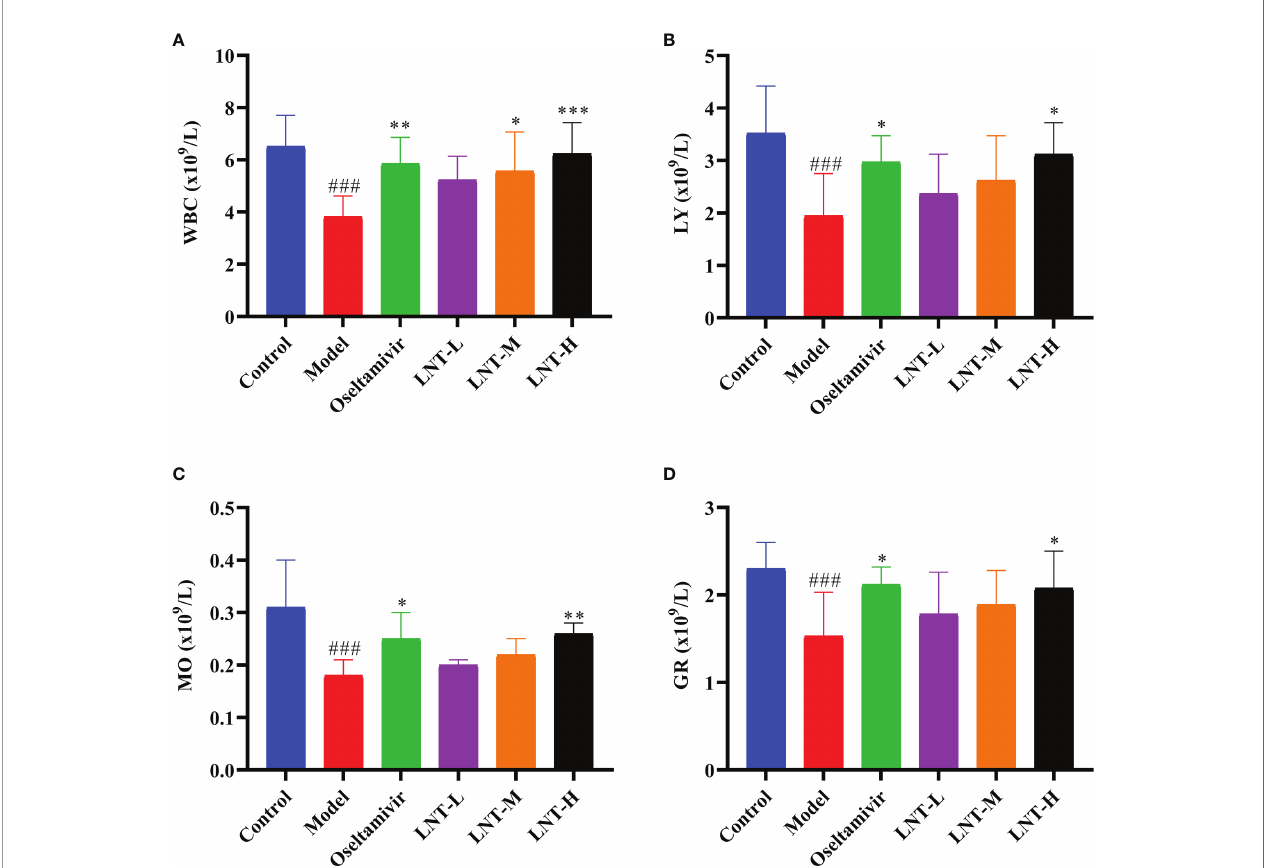
FIGURE 4 | Routine blood results of mice. At 5 dpi, EDTA anticoagulant blood was collected for routine blood testing. An automatic blood cell analyzer (BT-3200, Better, China) was used to detect the mouse samples. The blood cell data are shown in the fi gure. (A) White blood cells; (B) lymphocytes; (C) monocytes; (D) granulocytes. WBC stands for white blood cells, LY for lymphocytes, MO for monocytes and GR for granulocytes. ### p < 0.001, vs control group (n=10); *p < 0.05, **p < 0.01, ***p < 0.001, vs. model group